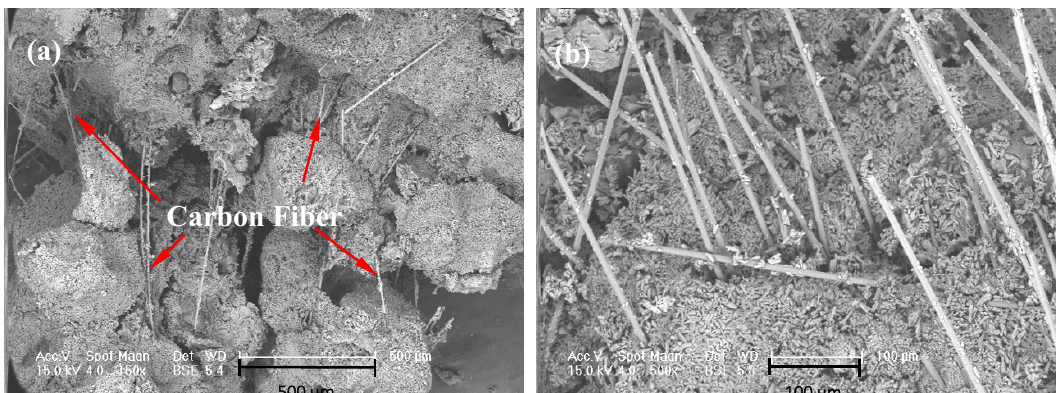
Figure 13. The microstructure of EGPG with CF (Carbon Fiber): ( a ) CF in the cracks of EGPG; ( b ) the surface of EGPG with CF after fracture.